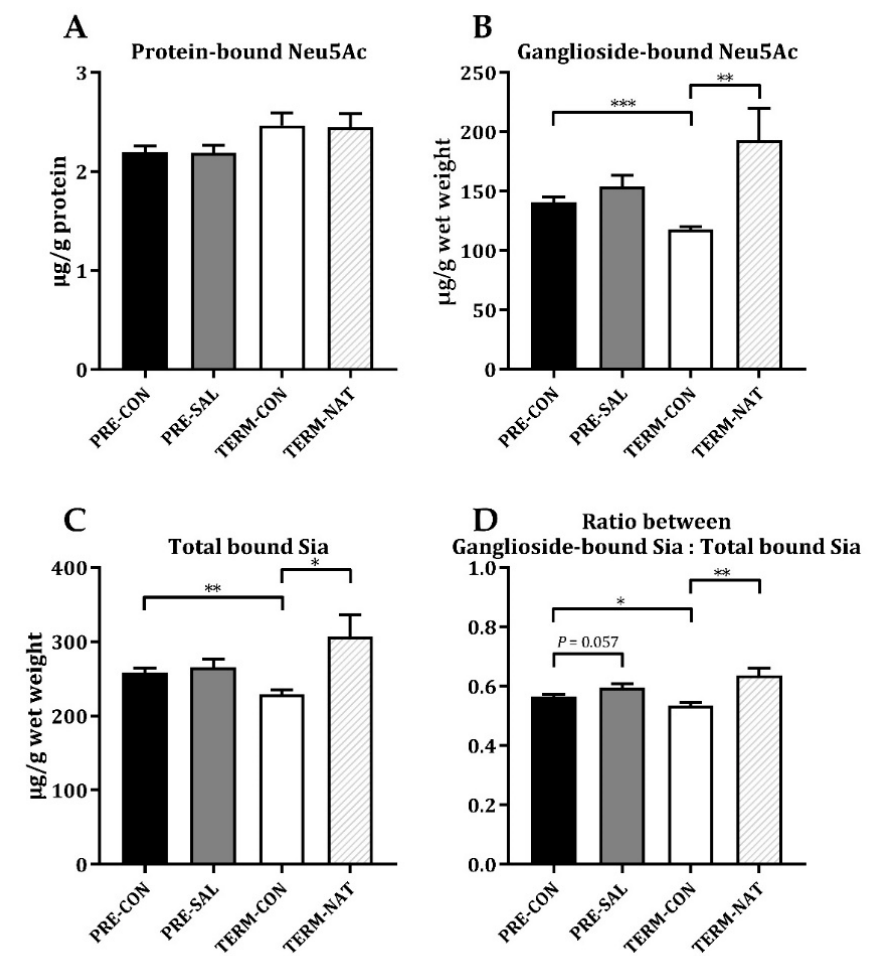
Figure 5. Sialic acid levels in hippocampal tissue. Protein-bound Neu5Ac ( A ), ganglioside-bound Neu5Ac ( B ), total levels of bound sialic acid ( C ), and ratio between the ganglioside-bound and total levels of bound sialic acids ( D ). Abbreviations: Neu5Ac; N-acetylneuraminic acid, Sia; sialic acid. Data are means ± SEM. Statistical difference * p < 0.05; ** p < 0.01; *** p < 0.001. Table 2. Sialic acid levels in hippocampal tissue. Values for protein-bound fractions are presented as µg/g protein whereas ganglioside-bound fractions are presented as µg/g wet weight tissue.